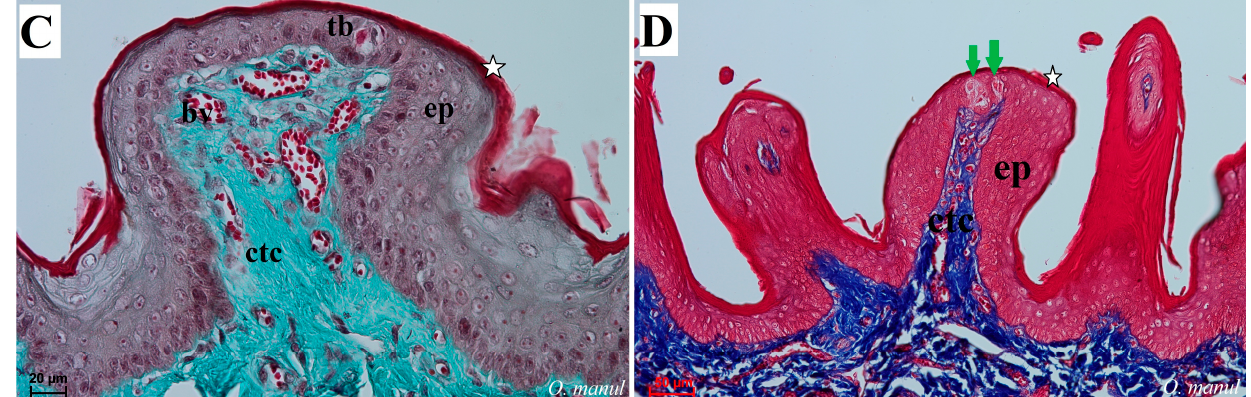
Figure 9. Histological picture of the fungiform papillae of the tongue of undomesticated species of Felidae: N. nebulosa ( A , B ) and O. manul ( C , D ). ( A ) Longitudinal section of the fungiform papilla with several taste buds within the epithelium. ( B ) Magnification of the fungiform papillae with two elongated-shaped taste buds (green arrow). Thin keratinized layer is visible (white asterisk). ( C ) Longitudinal section of dome-shaped fungiform papilla with numerous blood vessels within the connective tissue core of this papilla. Single taste bud present within the epithelium as well as a thin keratinized layer (white asterisk). ( D ) More elongated fungiform papillae with two taste buds. Azan trichrome staining ( A , B , D ); Masson–Goldner trichrome ( C ). Bar = 100 µ m ( A ); bar = 50 µ m ( D ); bar = 20 µ m ( B , C ). Abbreviations: bv—blood vessels, ctc—connective tissue core, ep—epithelium,